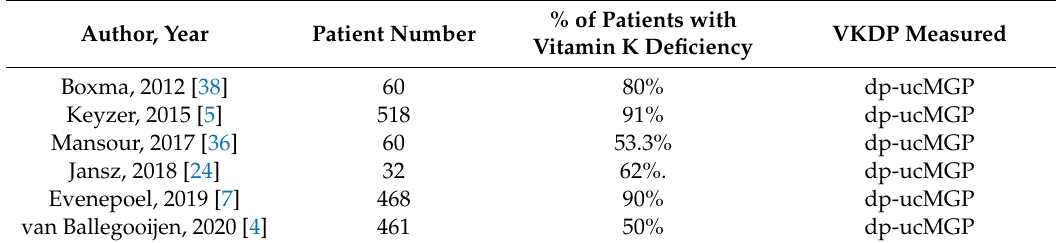
Table 3. Vitamin K status in kidney transplantation